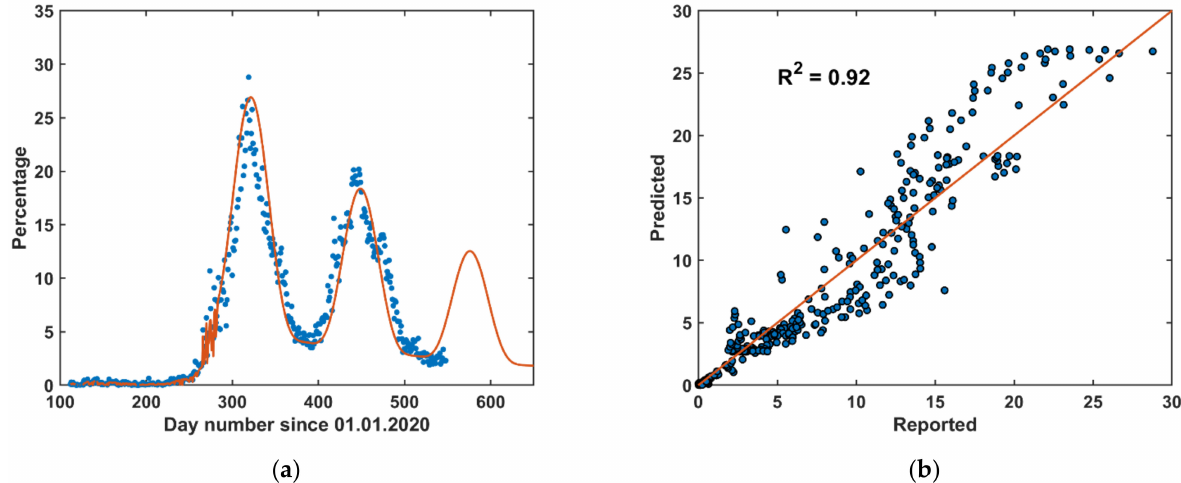
Figure 10. Hybrid forecast (HF) model: ( a ) is the time-series of the pandemic and ( b ) is the scatter plot between the predicted and the reported percentage of the daily positive qPCR daily